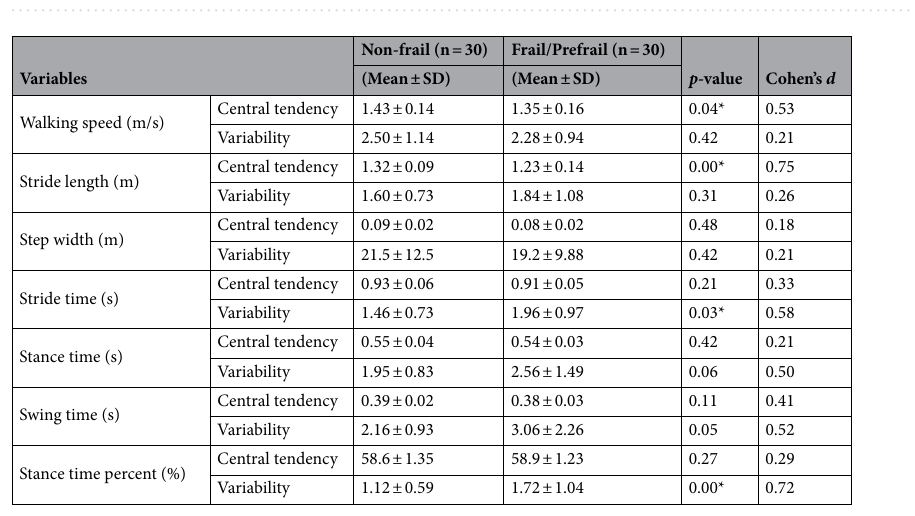
Figure 2. Waveforms of central tendency (average) recombined from the principal component scores of principal component vectors 6 and 9. The definitions of the abbreviations in the variability graph are as follows: Post. posterior tilt, Ant. anterior tilt, Flex. flexion, Ext. extension, D.F. dorsiflexion, P.F. plantarflexion, Hike. pelvic hike, Drop. pelvic drop, Add. adduction, Abd. abduction, I.R . internal rotation, E.R. external rotation, Ever. eversion, Inv. inversion.